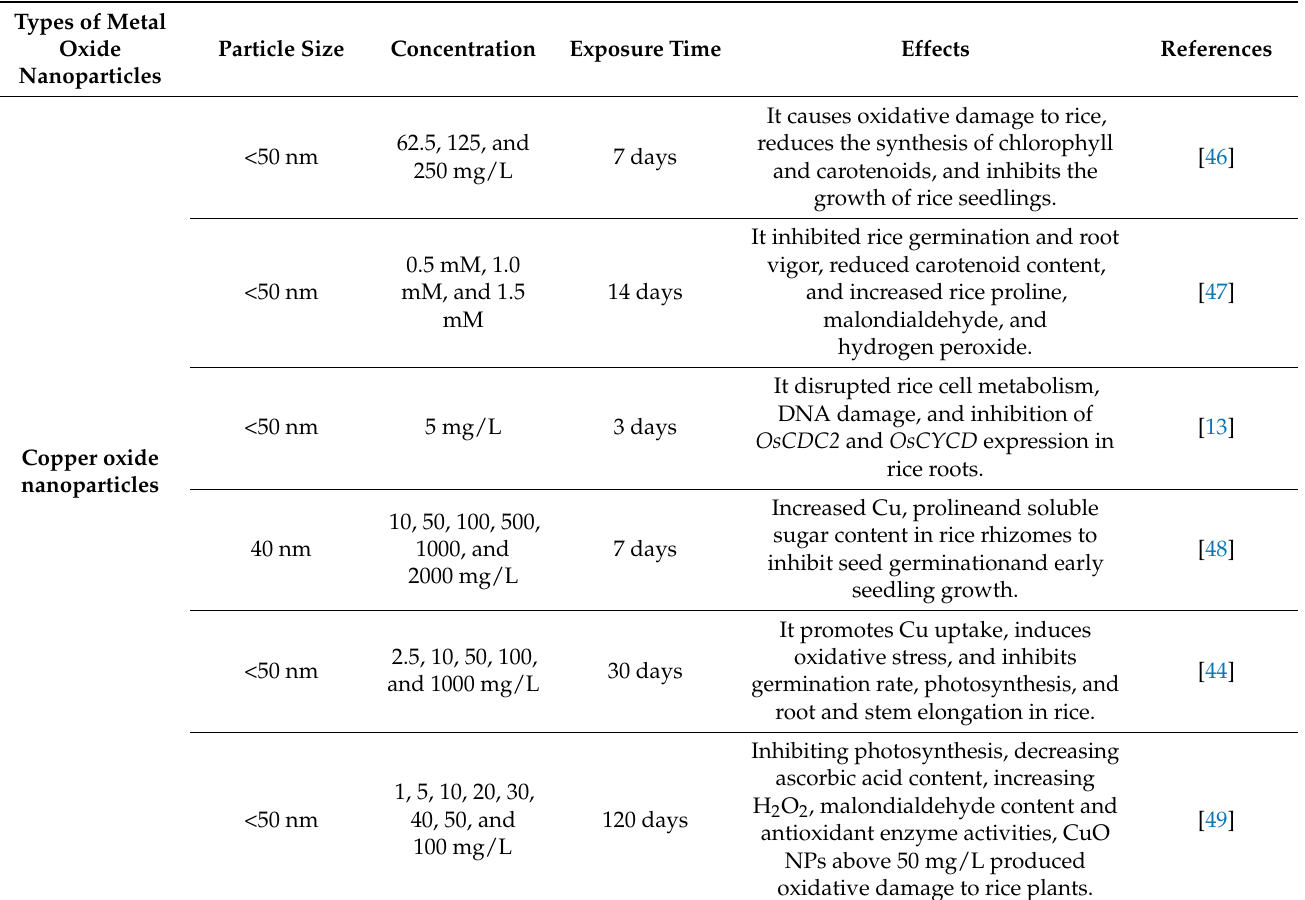
Table 1. Toxic effects of metal oxide nanoparticles on rice